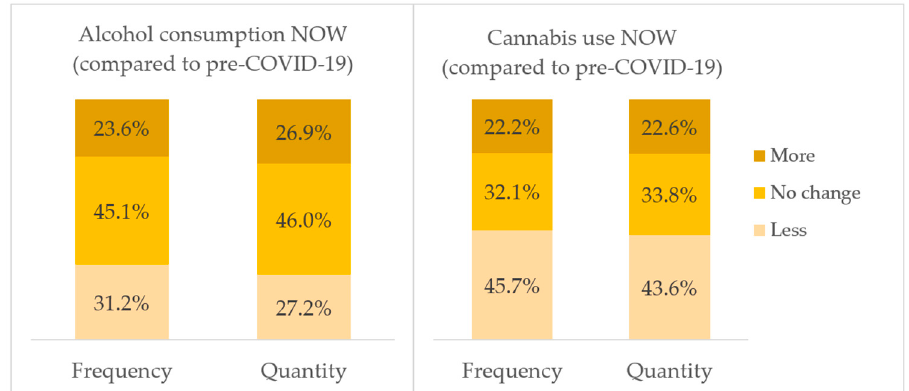
Figure 2. Self-reported changes in alcohol and cannabis use in relation to the COVID-19 pandemic in 2020 among Grade 12 students. Table 2. Ordinal logistic regression on increasing order of alcohol and cannabis use compared to